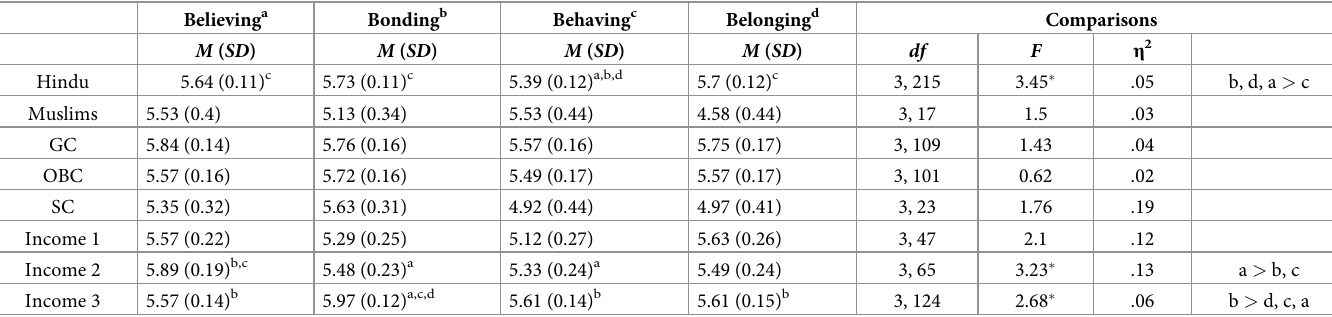
Table 18. The distribution and the comparison of the dimensions of religiousness in different groups among the community sample. Believing a Bonding b Behaving c